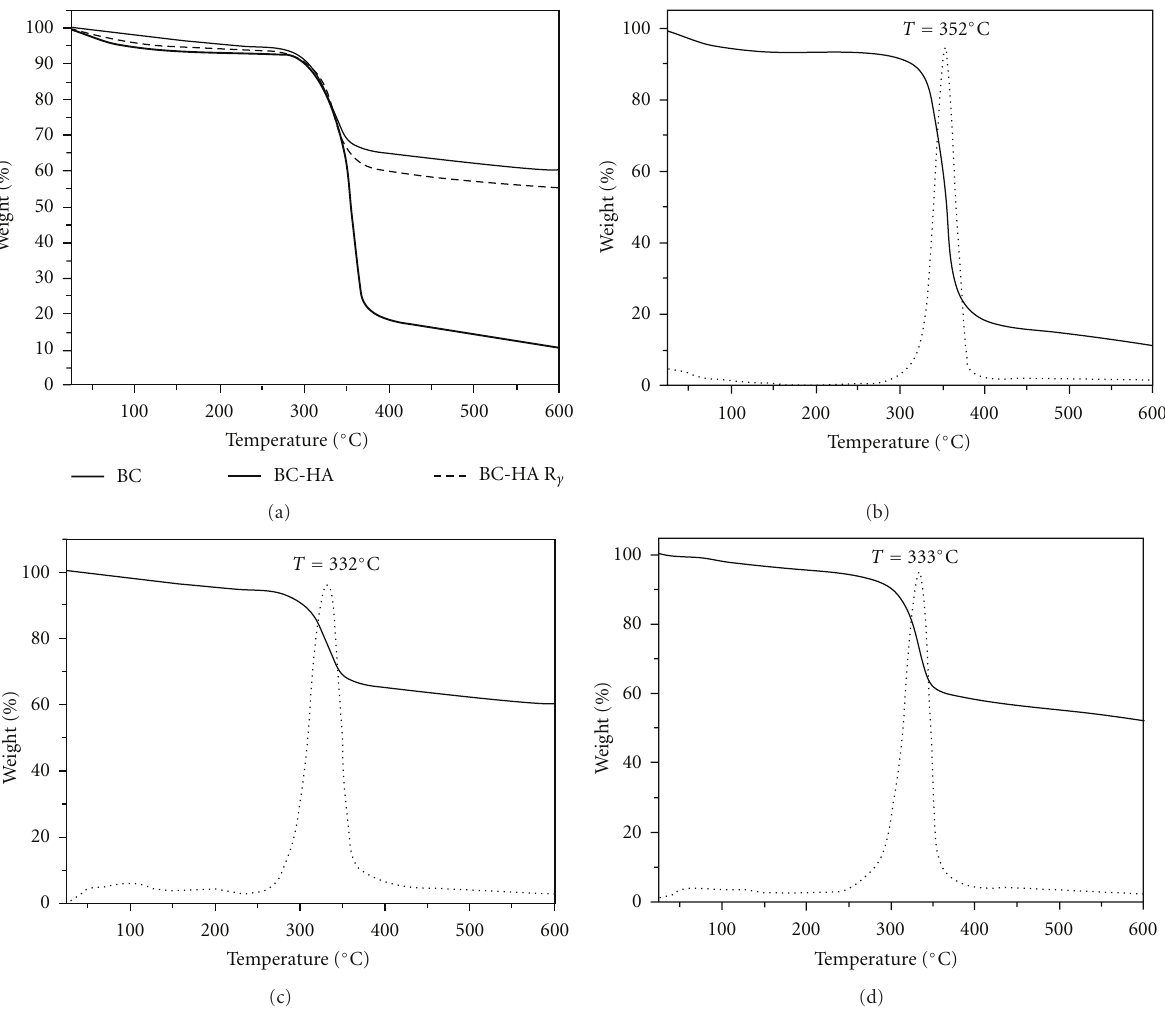
Figure 1: (a) TG curves: (thick line) bacterial cellulose (BC), (solid line) BC-HA and (dashed line) BC-HA sterilized by 20kGy gamma radiation (BC-HA γ ); TG curve (solid line) and DTG curve (dashed line) of BC (b), BC-HA (c) and BC-HA γ